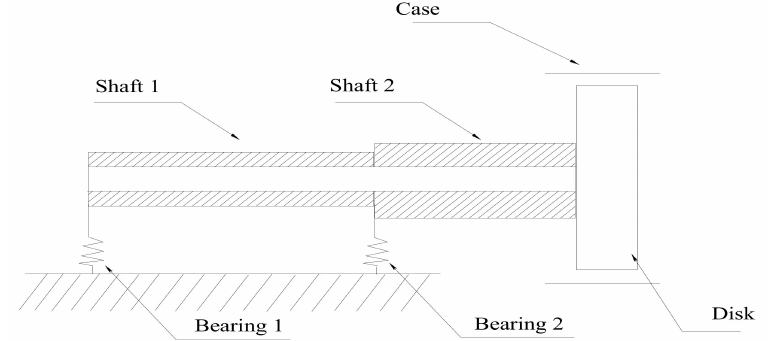
Figure 1. Schematic diagram of the rubbing rotor.